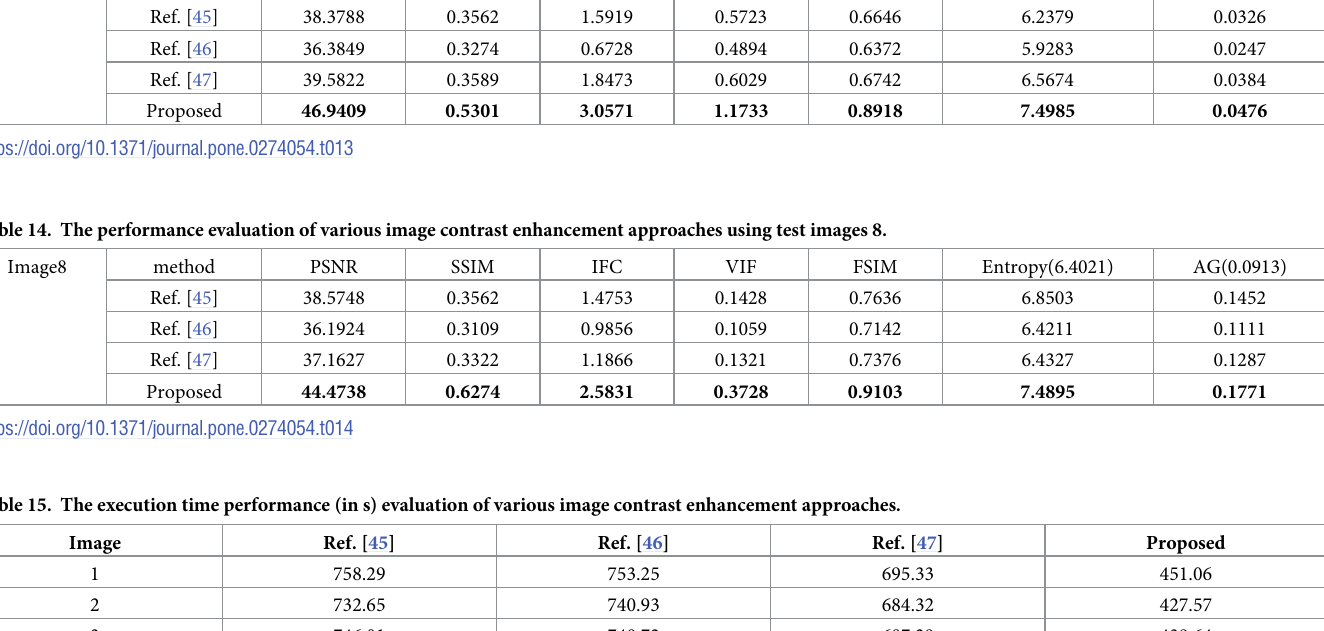
Table 13. The performance evaluation of various image contrast enhancement approaches using test images 7. Image7